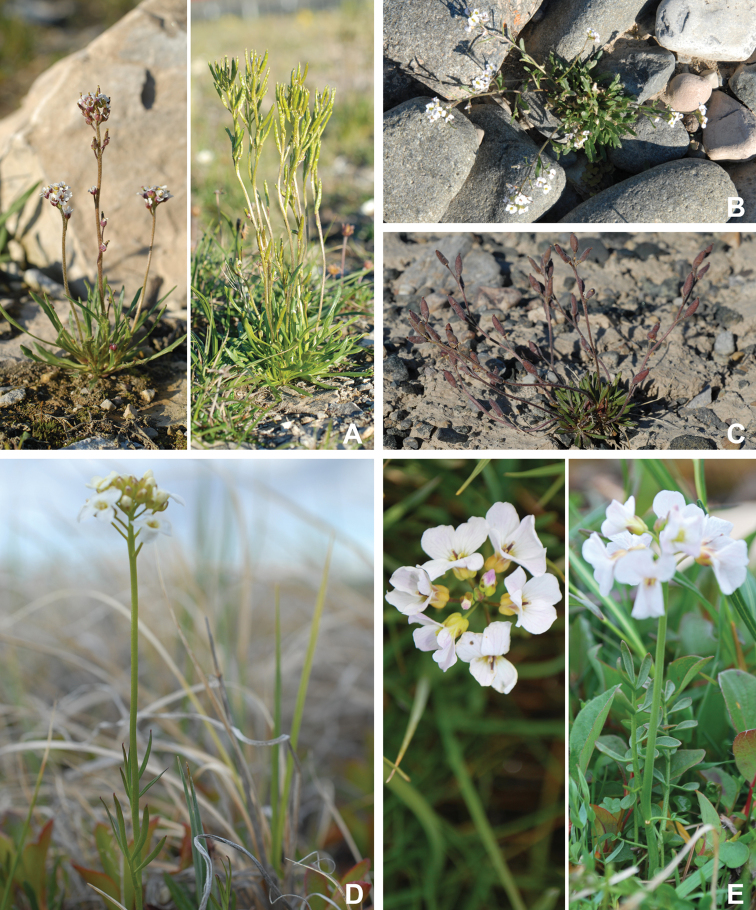
ABraya
glabella
subsp.
glabella habit (left, Gillespie et al. 8493; right, Gillespie et al. 8492) BBraya
humilis
subsp.
humilis habit, Gillespie et al. 10170CBraya
thorild-wulffii
subsp.
thorild-wulffii habit, Gillespie et al. 10074DCardamine
digitata habit, Gillespie et al. 7498ECardamine
polemonioides inflorescence (left) and habit (right). Photos A–C by L.J. Gillespie D by R.D. Bull and E by B.A. Bennett.